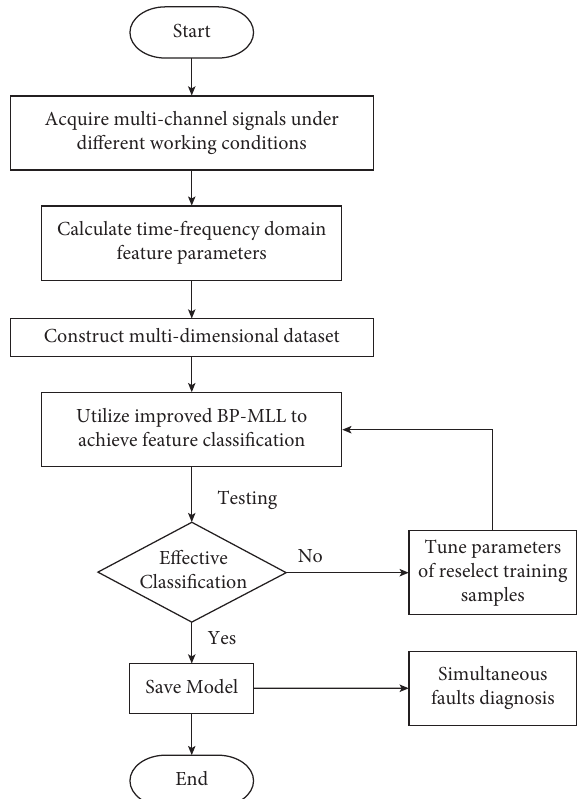
Figure 2: Training flow chart of the proposed